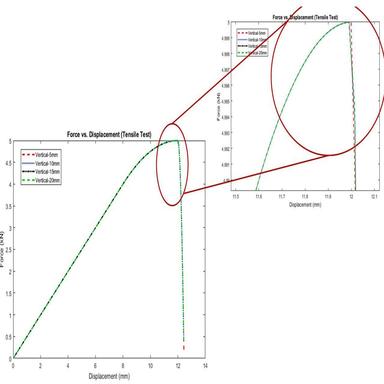
Tensile test results of the sample with different initial notch sizes.